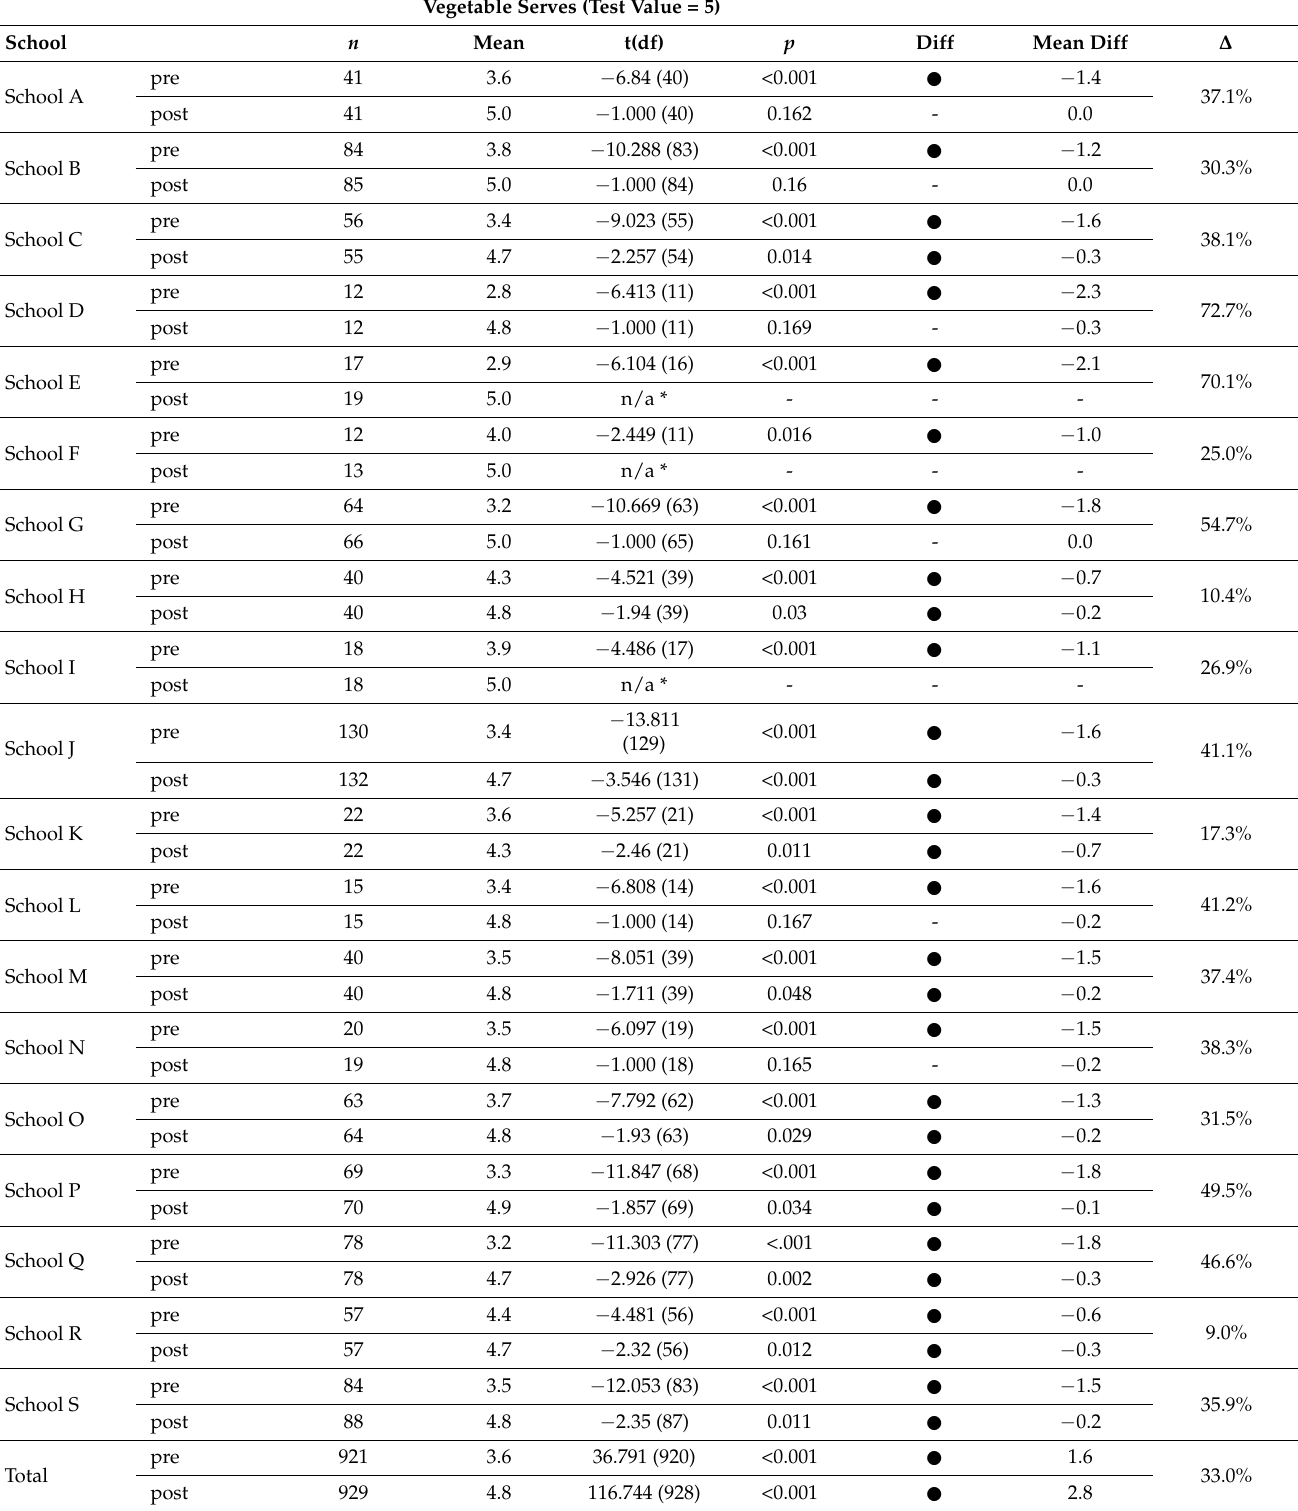
Table 5. One Sample t-Test results vegetables—Nutrition